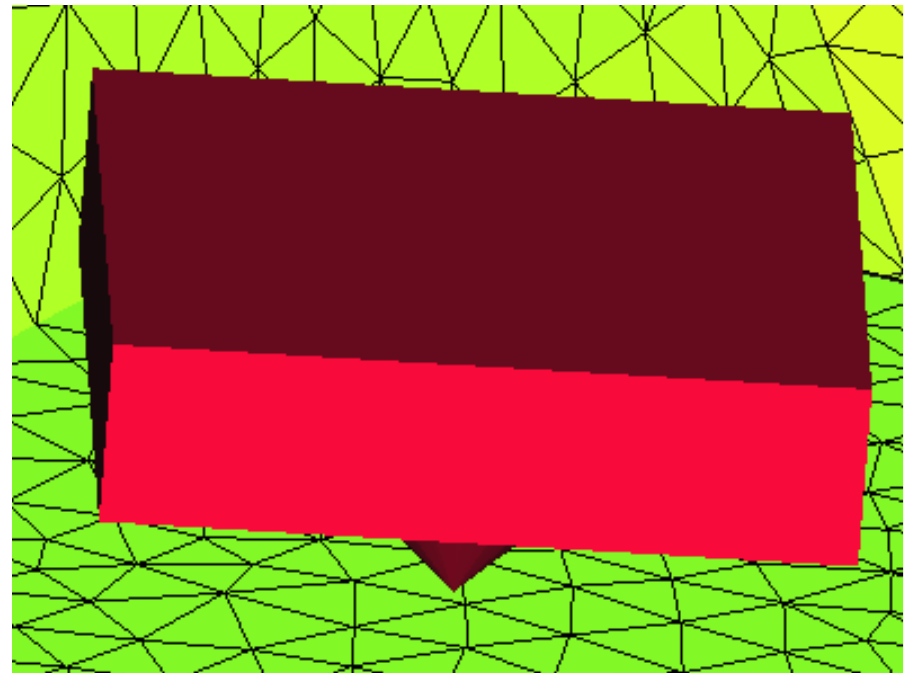
Figure 3. Locking on the surface of three out of four implants.